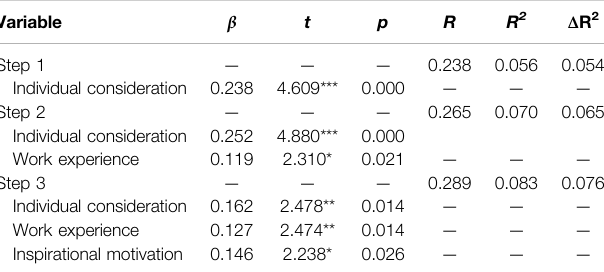
TABLE 2 | Summary of hierarchical regression analysis for variables predicting motivation for complementary tasks.